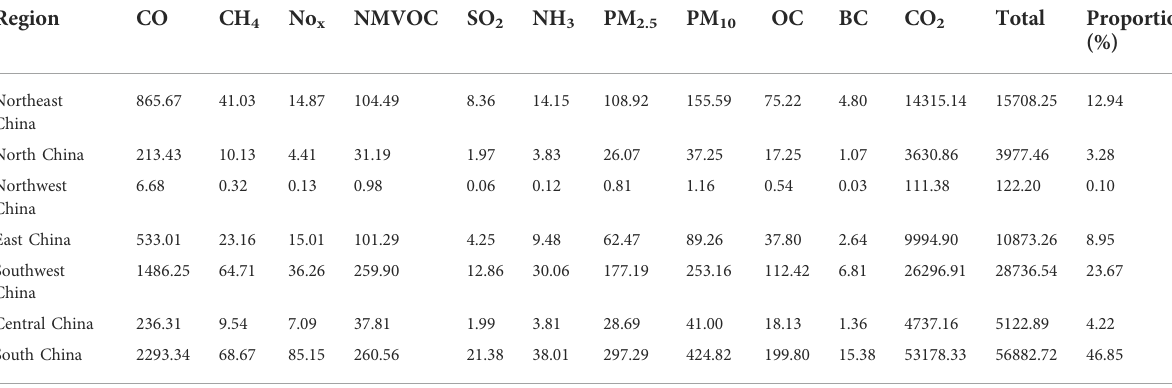
TABLE 5 Amount of pollutant emissions in the various regions (Unit: